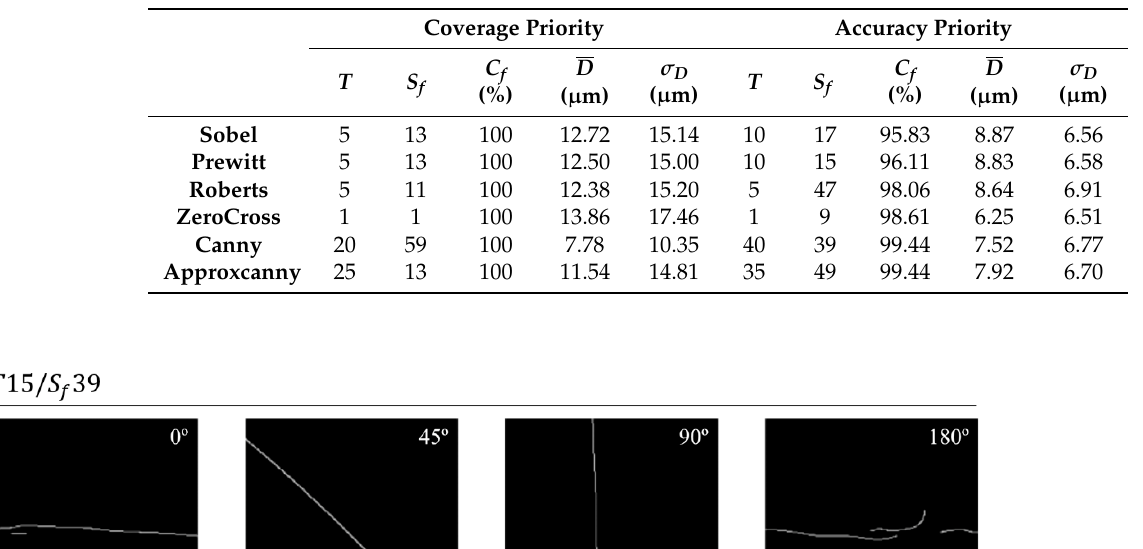
Table 4. Optimal combinations of test parameters for S 02.